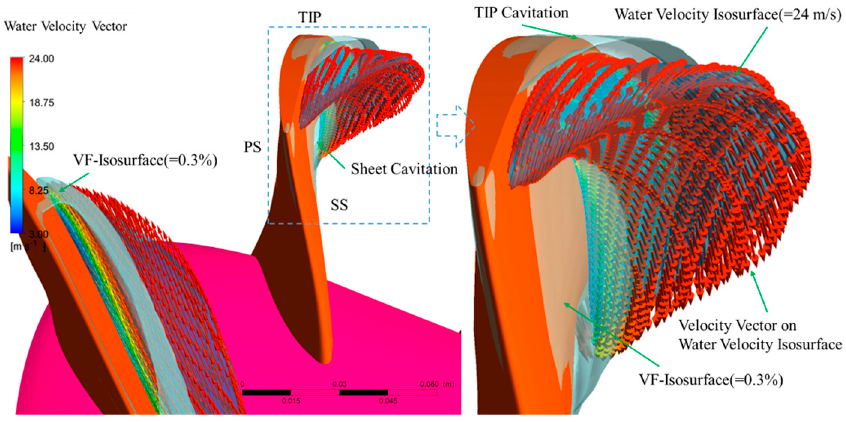
Figure 4. Cavitation and high-velocity vortex interaction